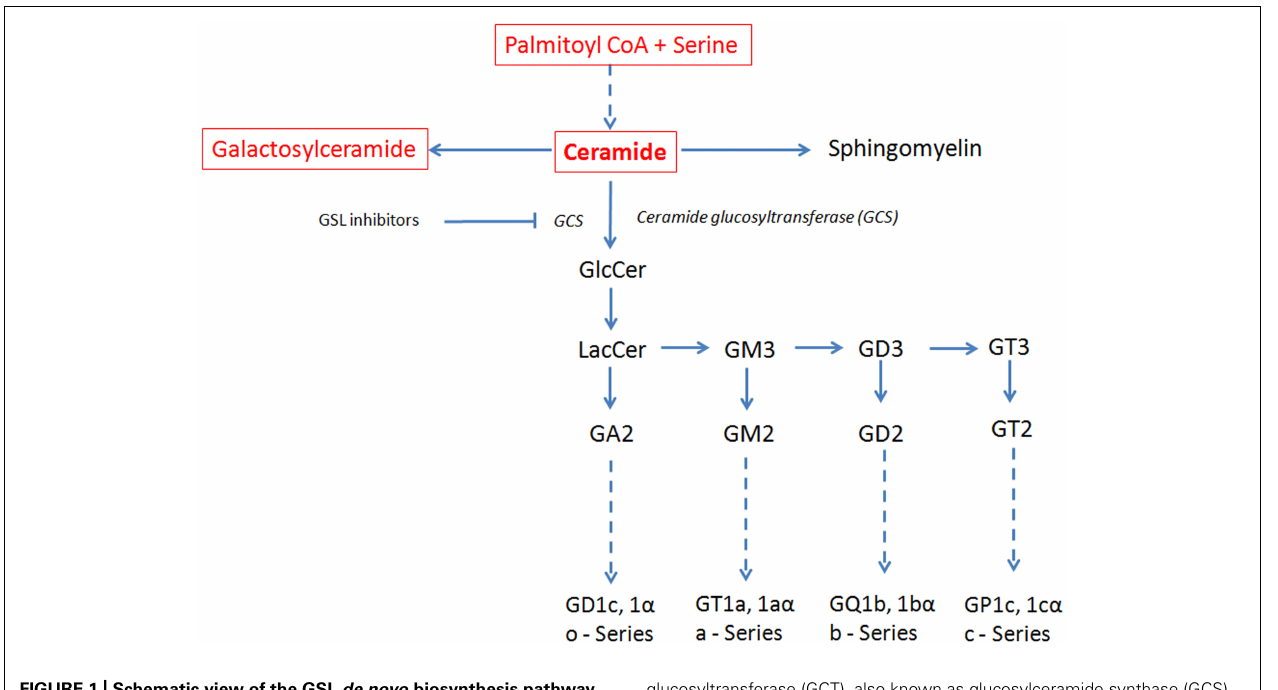
FIGURE 1 | Schematic view of the GSL de novo biosynthesis pathway. Ceramide, the metabolic precursor of complex sphingolipids, occupies a central position in the GSL biosynthesis. Ceramide synthesis occurs in the ER, while at the level of cis -Golgi apparatus GlcCer is generated that is converted in LacCer in the trans -Golgi.The reactions involving ceramide transformation into all major classes of GSL are catalyzed in the lumen of the Golgi apparatus by membrane-bound transferases. Ceramide